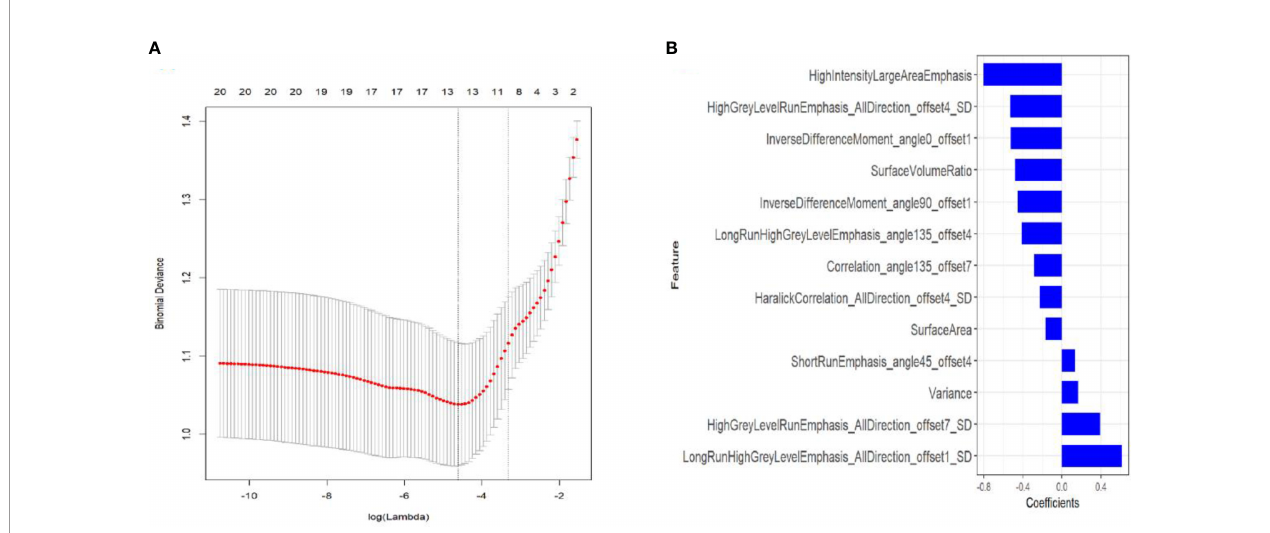
FIGURE 2 | Textural feature selection using least absolute shrinkage and selection operator (LASSO) binary logistic regression. (A) Tuning parameters ( l ) for the LASSO model were selected by 10-fold cross-validation using the minimum criteria. Partial likelihood deviance was plotted against log ( l ). The dotted vertical lines correspond to the optimal values according to the minimum criteria and 1-SE criterion. The 10 features with the smallest binomial deviance were selected. (B) LASSO coef fi cient pro fi les of texture features. Vertical lines correspond to the values selected by 10-fold cross-validation of the log ( l ) sequence; the 10 non- zero coef fi cients are